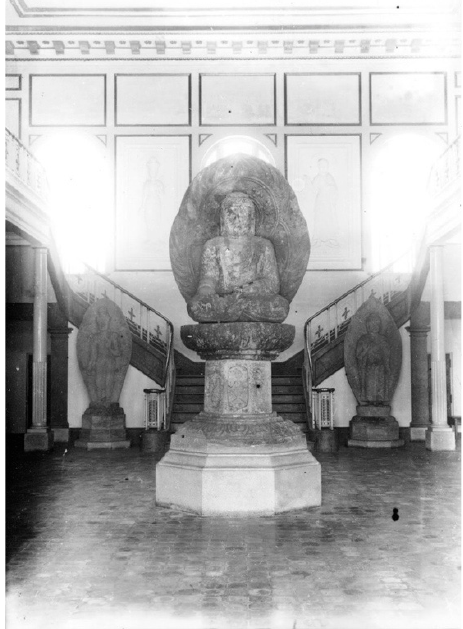
Figure 2. Seated Buddha from Samn˘unggye valley on Mount Nam. 8–9th century, Unified Silla. Displayed at Chos˘on Industrial Exhibition, 1915. Gelatin dry plate from the colonial period. Courtesy of National Museum of Korea.